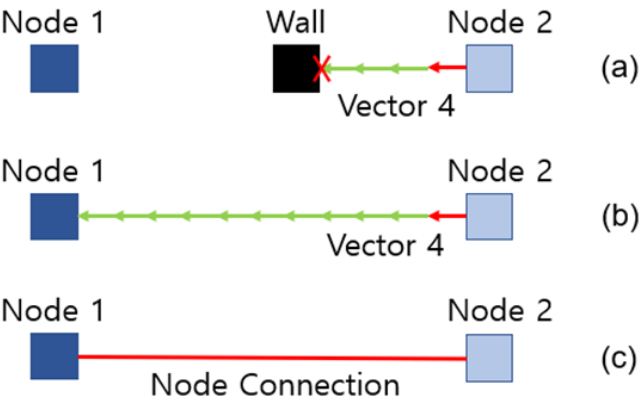
Figure 7. Connecting two nodes: ( a ) when there is an obstacle between Nodes 1 and 2, ( b ) when there is no obstacle between Nodes 1 and 2, and ( c ) the result of connecting the nodes.